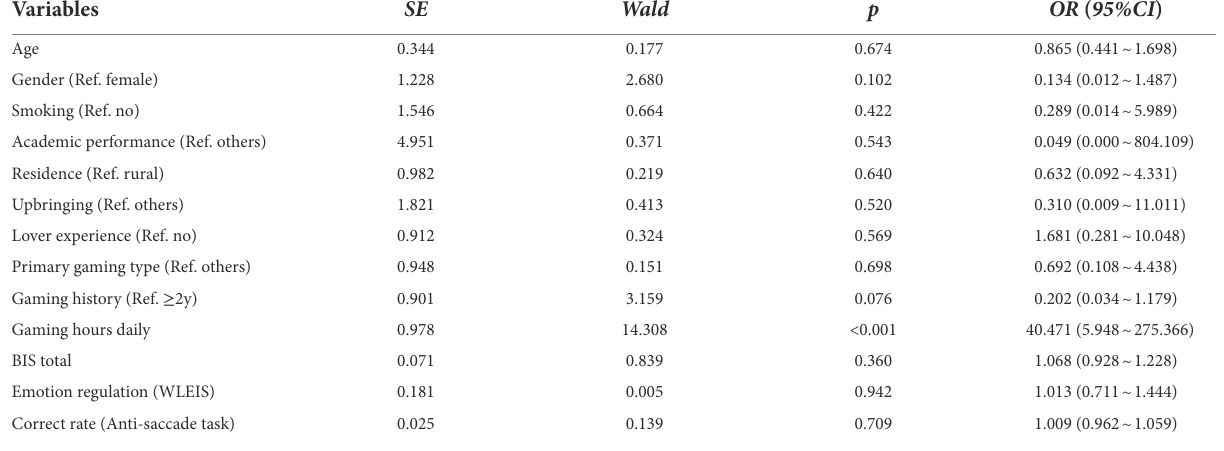
TABLE 5 Logistic regression analysis of developing to